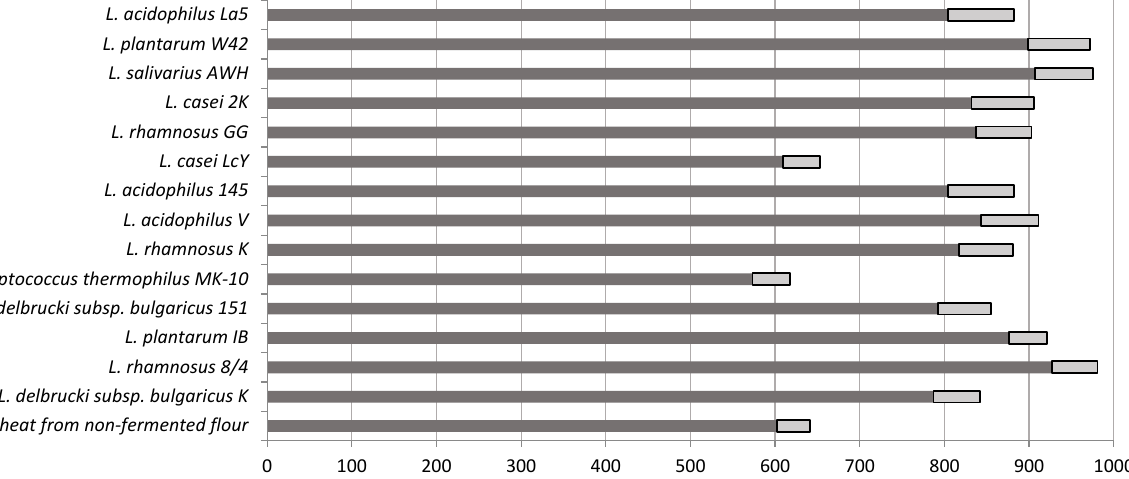
Figure 1. The summed-up content of phenolic acids and flavonoids in buckwheat biscuits prepared from fermented flours by selected lactic acid bacteria.